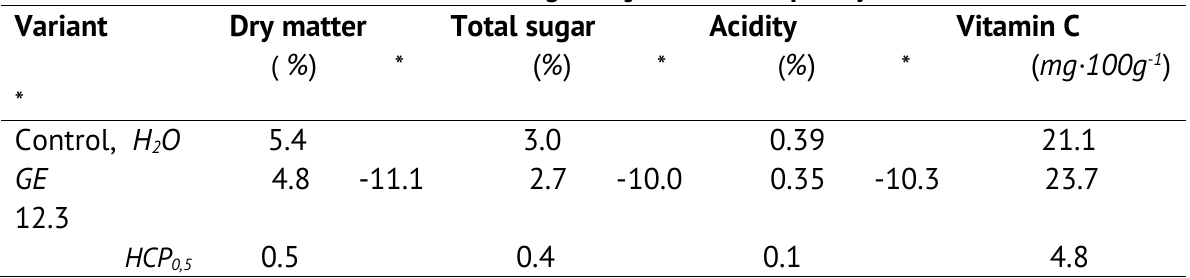
Influence of GE from Linaria genistifolia on the quality of tomato